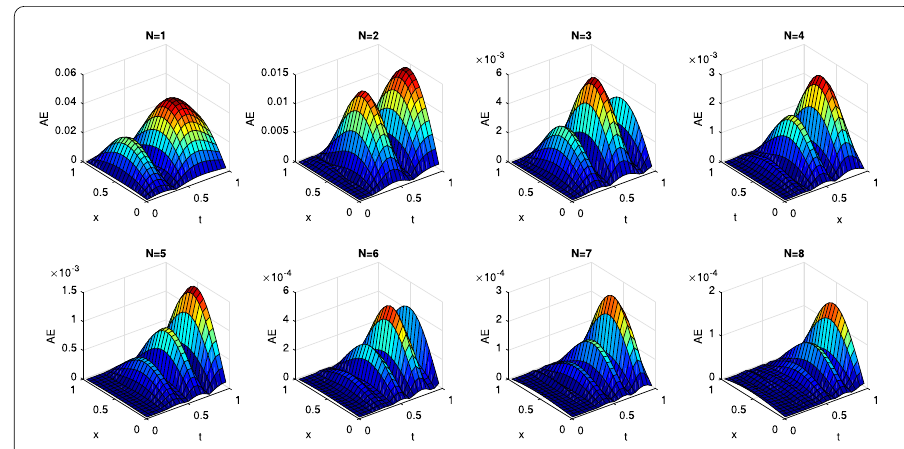
Figure 1 Absolute errors(AE) for different values of N , α = 1, k = 3, M = 5 in Example 1